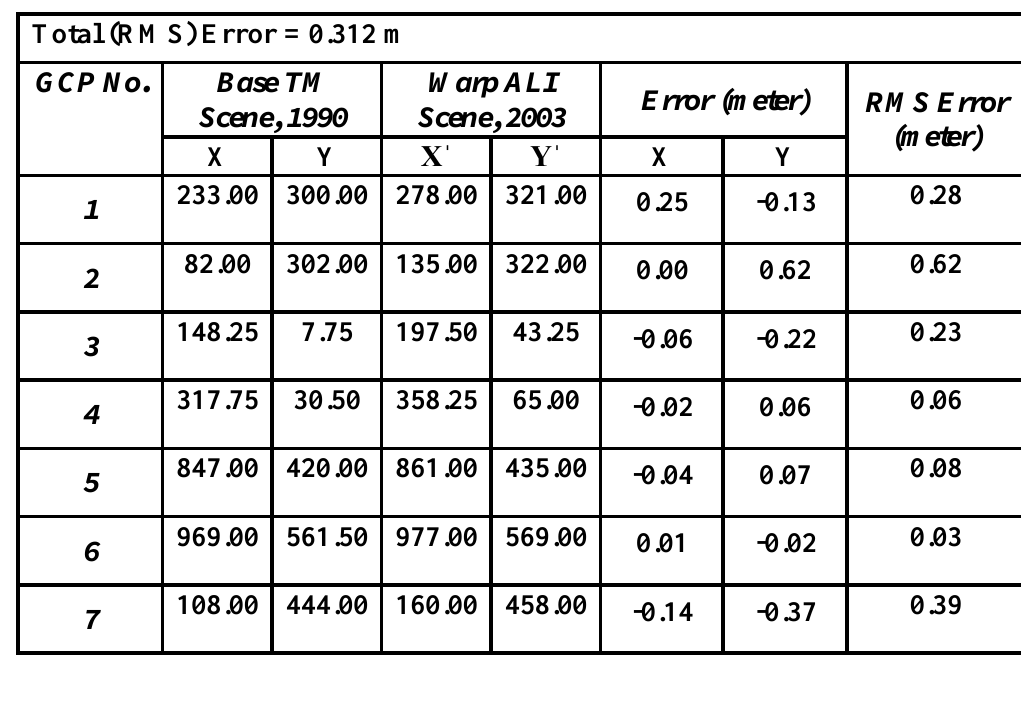
Table 1: Al habbaniyah Lake Region Registration